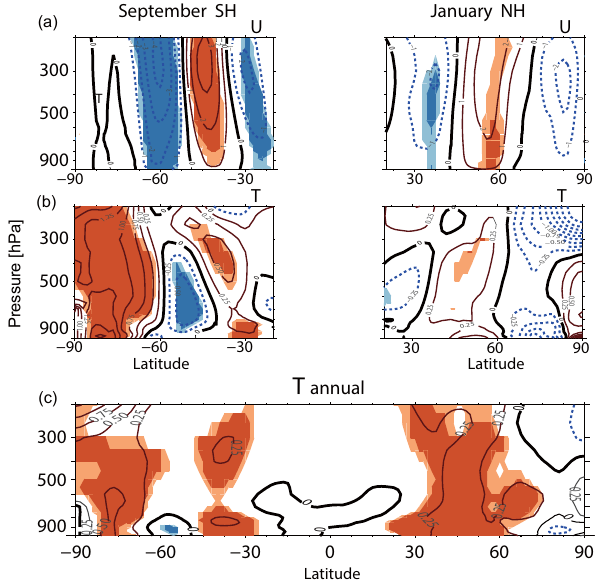
Figure 15. (a) Same monthly solar regression coefficient of zonal mean zonal winds as in Fig. 6, except for the tropospheric part: (left) SH in September, and (right) NH in January. (b) Same as in (a) , except for the temperature signal in Fig. 7. (c) Tropospheric part of solar regression coefficients of the annual zonal mean air temperature in Fig. 5a. Contour intervals are 0.25K for temperature and 1ms − 1 for